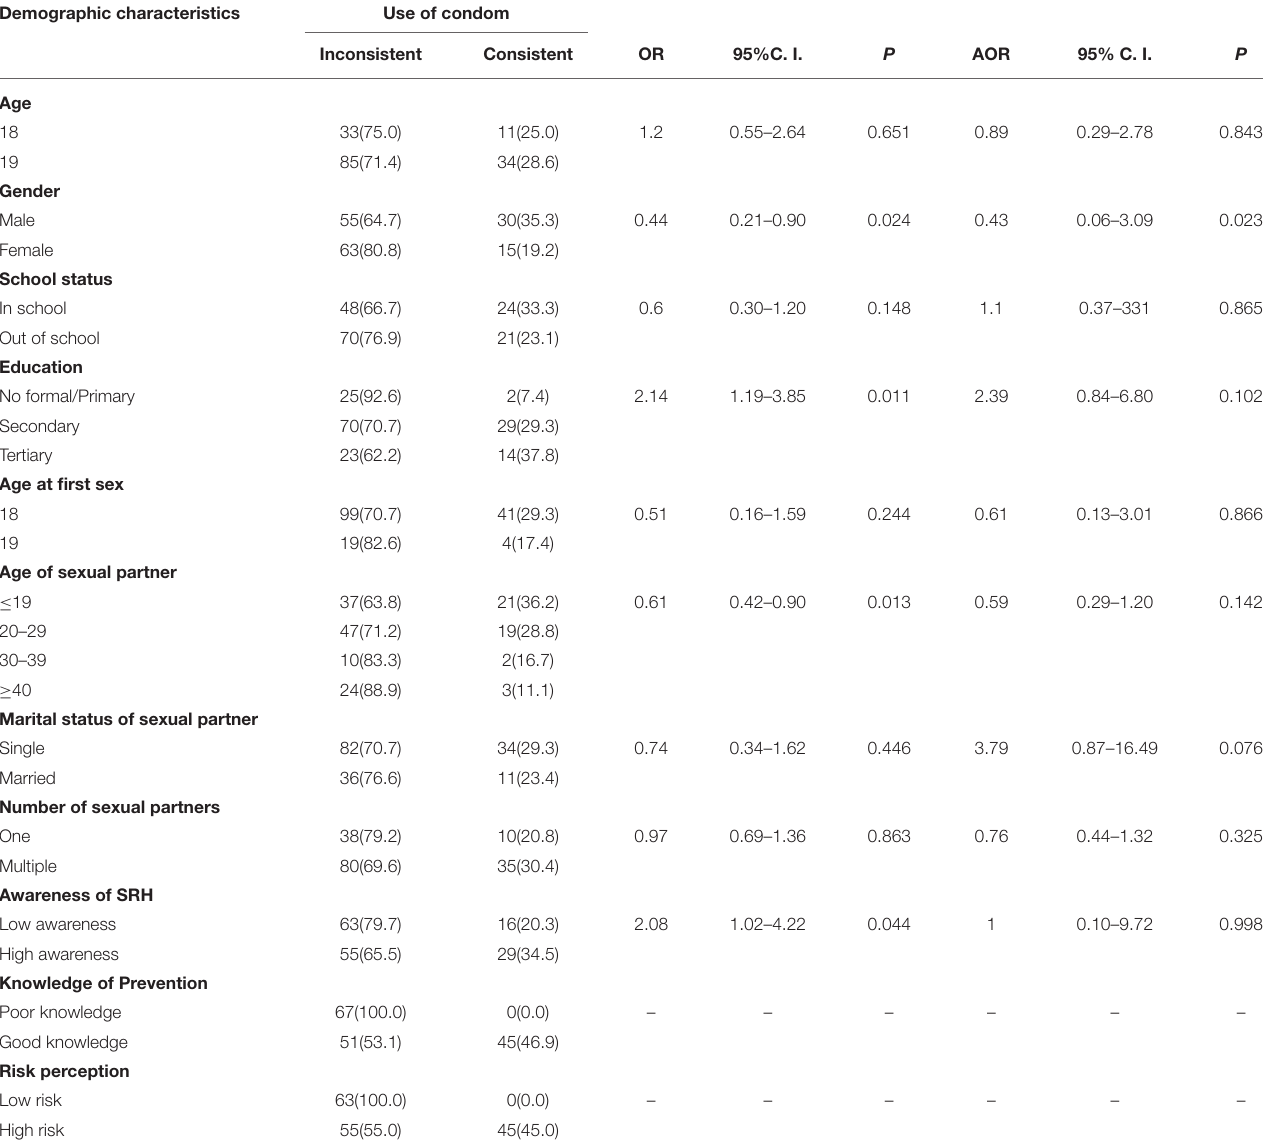
TABLE 4 | Covariates of consistent condom use among sexually active adolescents in Plateau State ( N = 163). Demographic